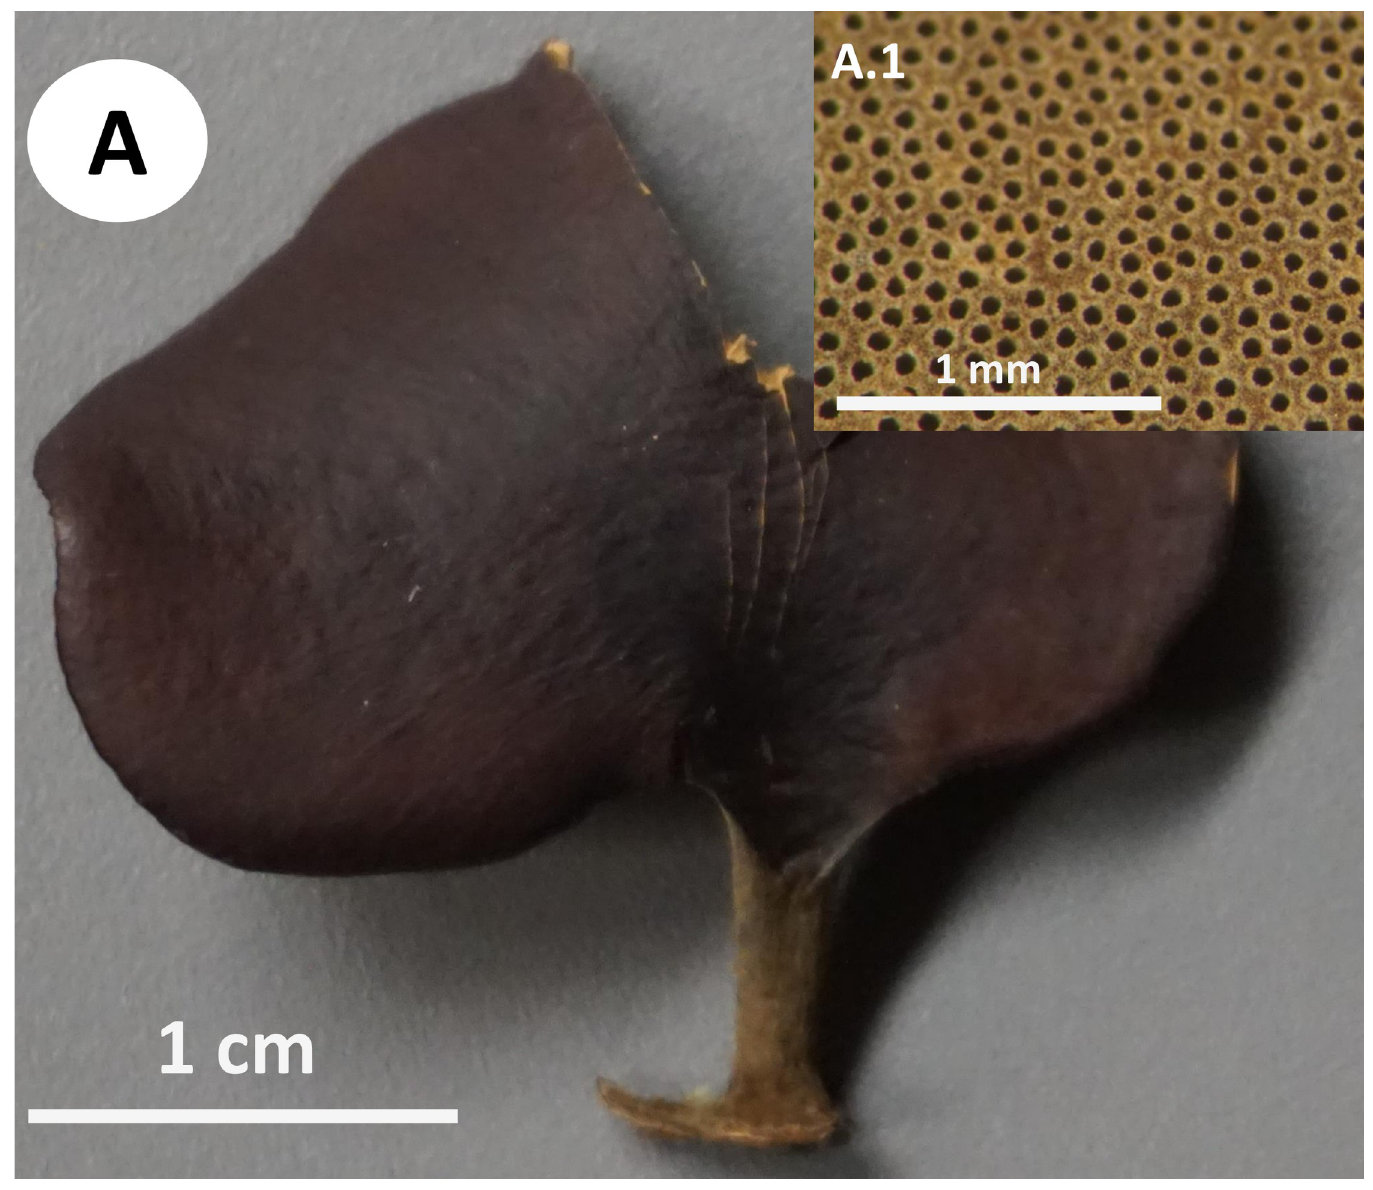
Fig 9. Basidiomata of Neodictyopus sp. Ec-97. A. Dried basidiome. A1 Pore